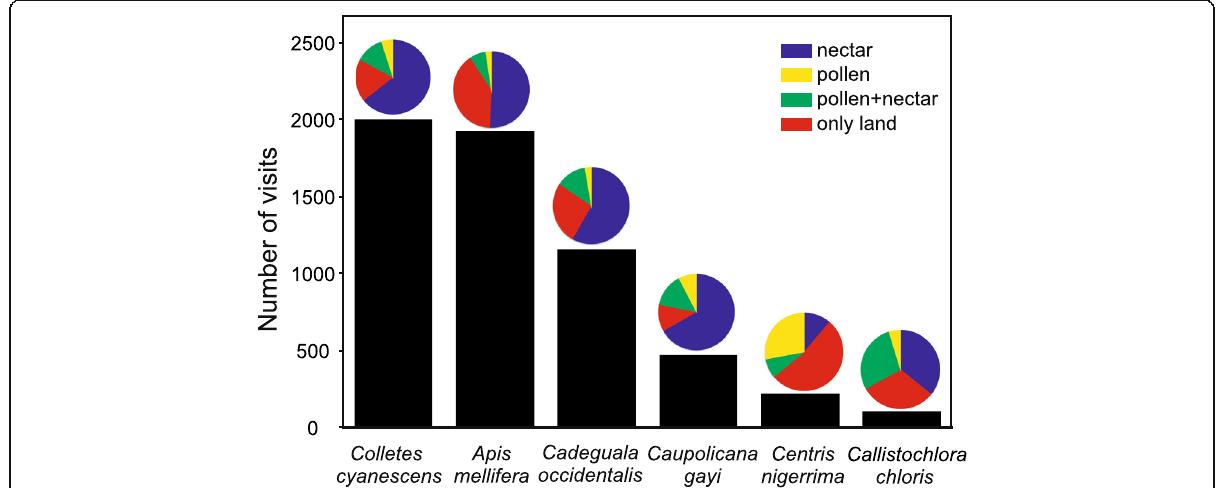
Fig. 3 Floral resources collected by bee species in avocado flowers, Hijuelas orchard, Valparaíso Region, Chile. Black bars represent the number of visits recorded per bee species while corresponding pie charts shows the resource(s) collected during these visits (nectar, pollen, pollen and nectar or only land). We considered “ only land ” to be when a bee landed on a flower and did not collect any resource